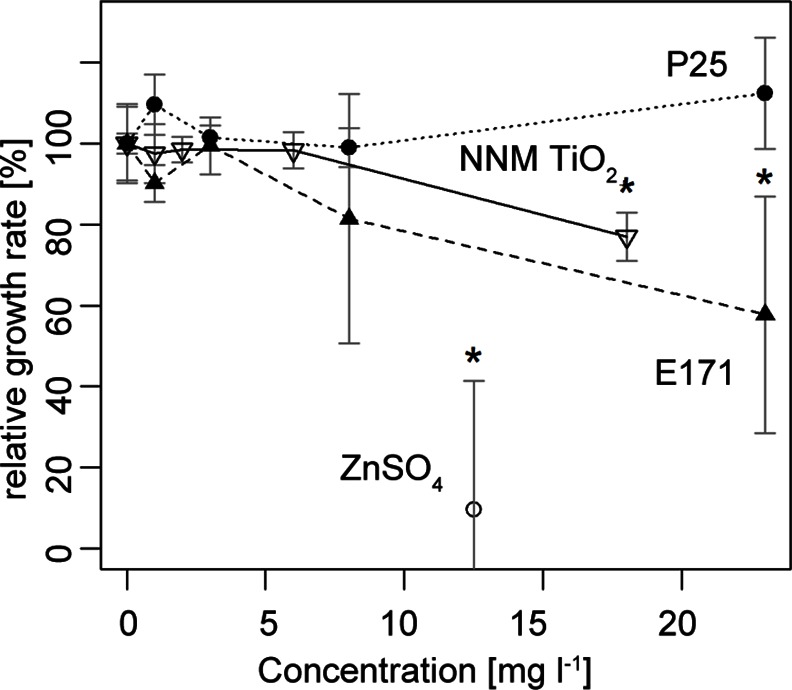
Relative growth rates of R. trifolii in YMB medium over a 32 h exposure assessed by optical density.R. trifolii growth rates were assessed in medium containing different actual concentrations and qualities of TiO2 NPs (P25 filled diamond, E171 filled triangle, NNM TiO2 inverted triangle, ZnSO4*7H2O circle) during the 34 h (n = 4). Stars indicate significant (p<0.05) differences from the control. Exponential growth curves are shown in S1 Appendix.